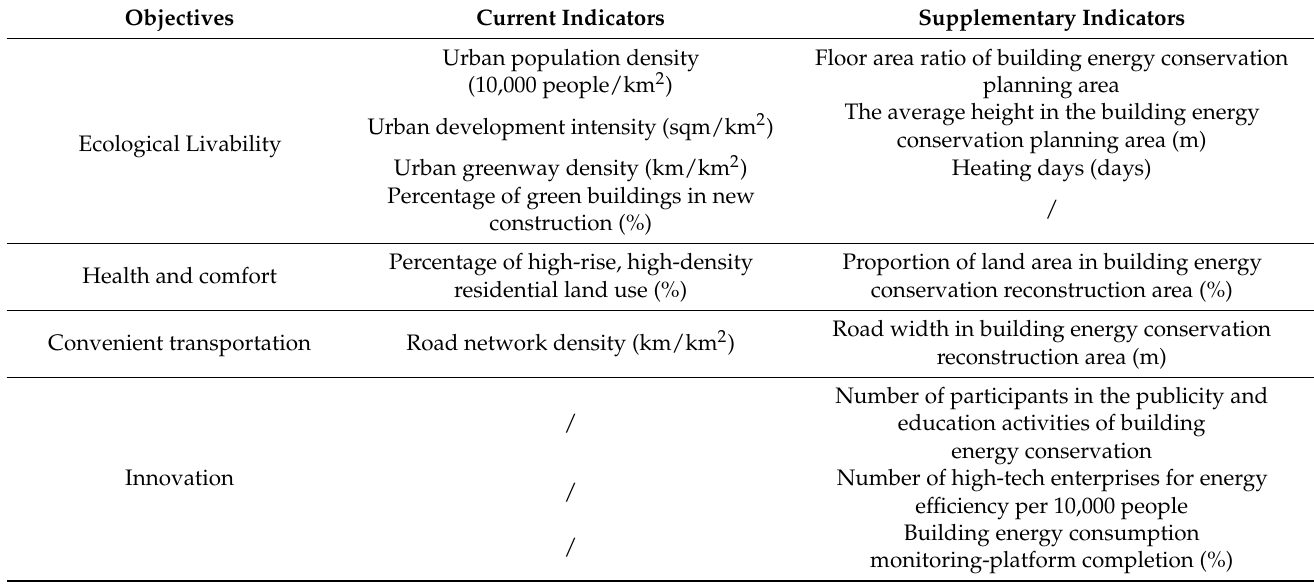
Table 7. Suggested urban physical examination indicators related to building energy